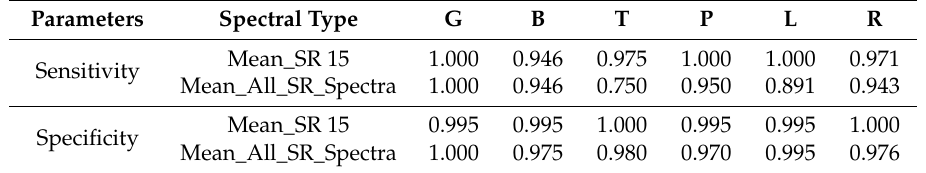
Table 4. Performance of the SVMDA models developed by optimal mean_SR spectra and mean all SR spectra a .